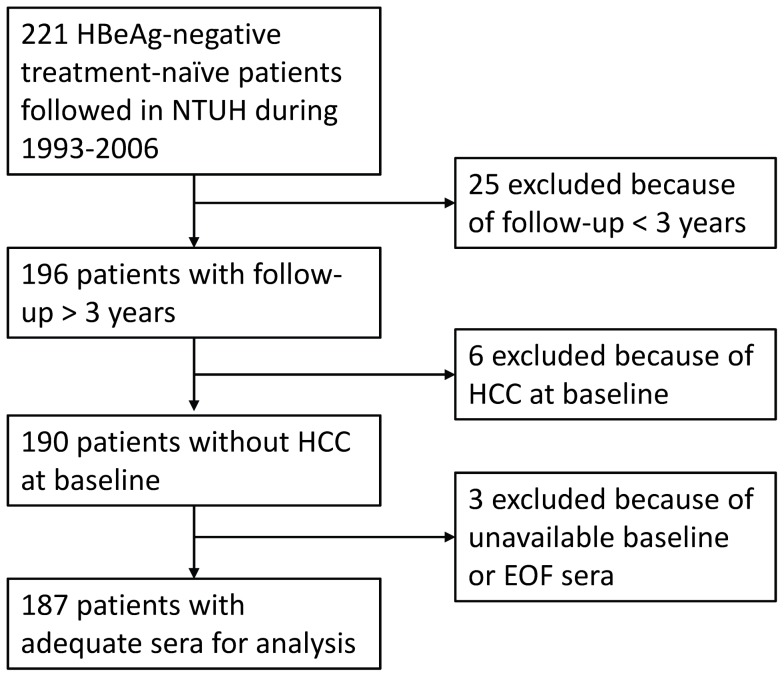
The flow chart of patient enrollment. EOF = end-of-follow-up, HCC = hepatocellular carcinoma.